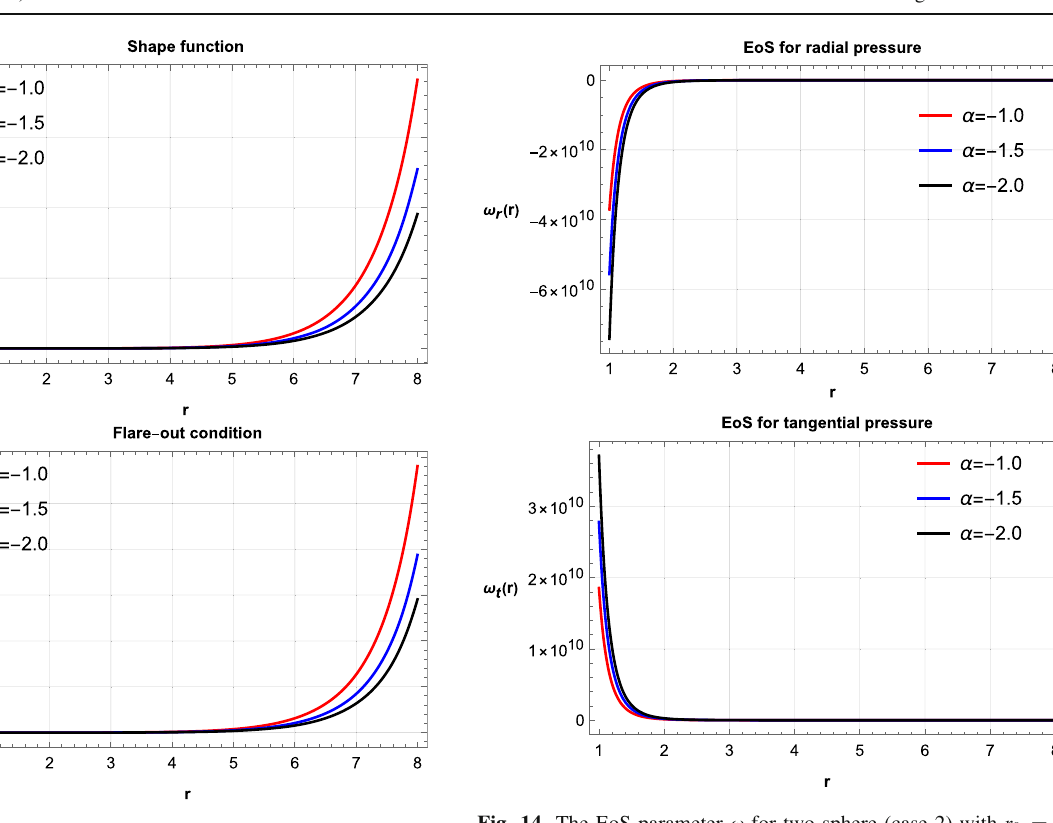
Fig. 13 Shape function and flare-out condition for two sphere (case-2) with r 0 = 1 and D = 20